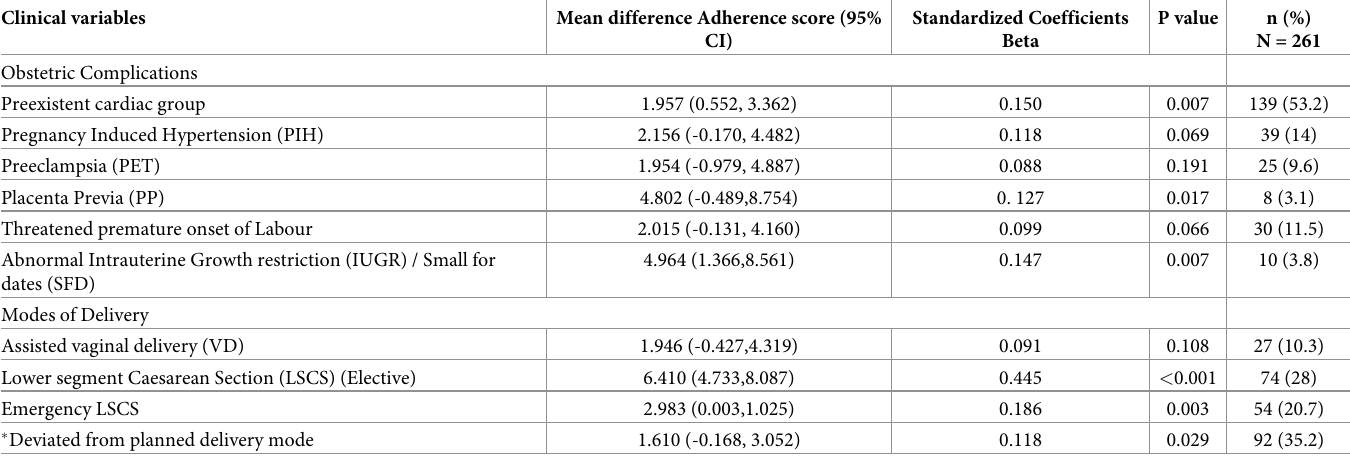
Table 3. Multivariable linear regression model results for the adherence score versus obstetric clinical